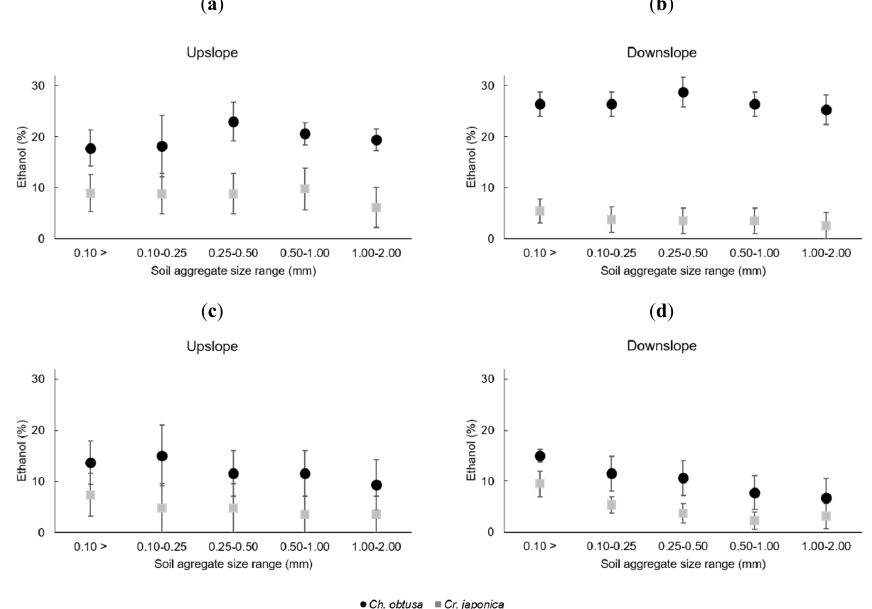
Figure 7. Soil moisture content (m 3 m − 3 ) at 5 cm soil depth upslope and downslope of individual Ch. obtusa trees ( a ), individual Cr. japonica trees ( b ), individual Ch. obtusa stumps ( c ) and individual Cr. japonica stumps ( d ). Down arrows indicate the rain event on 22 July.